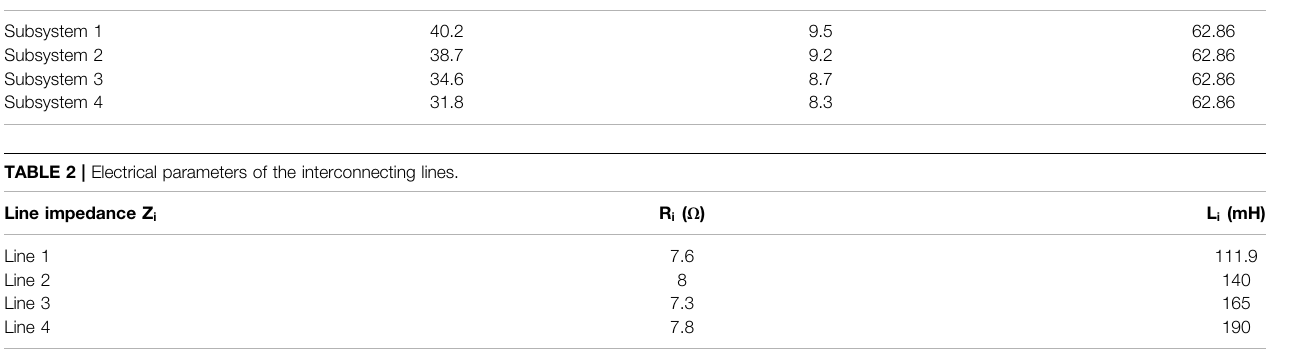
TABLE 3 | The reference values of state variables in each subsystem.